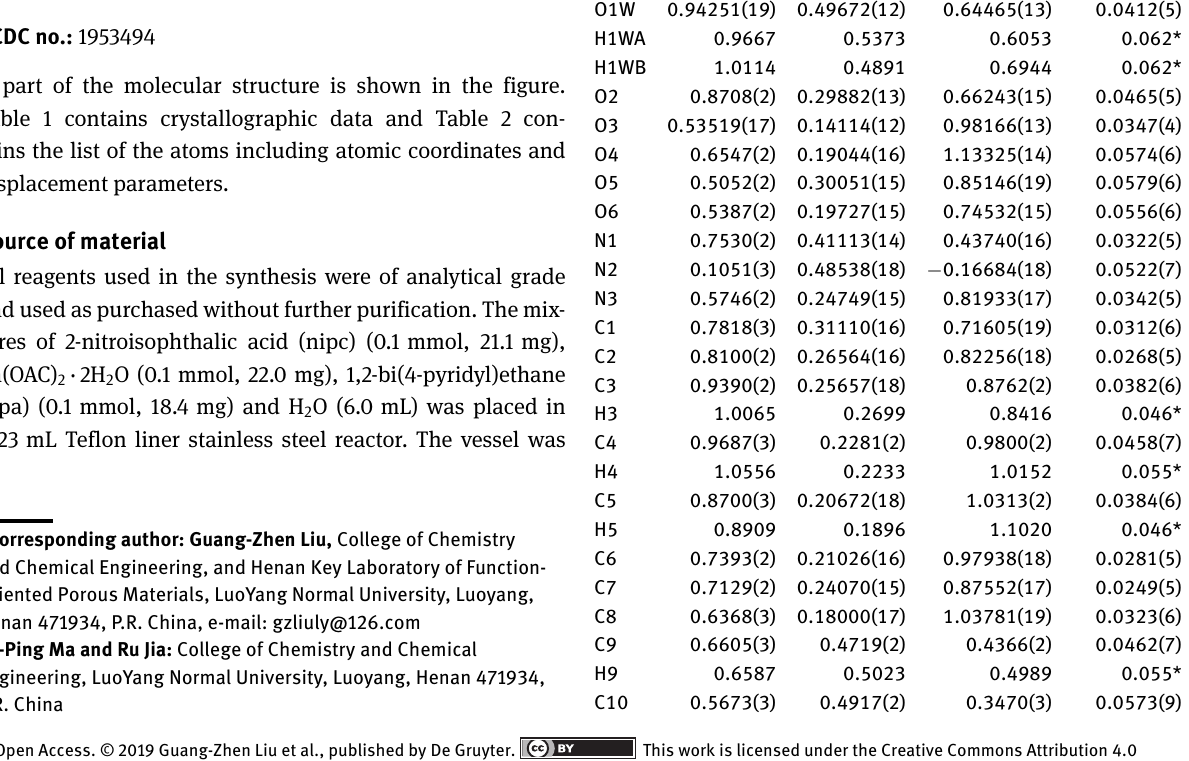
Table 1 contains crystallographic data and Table 2 con- tains the list of the atoms including atomic coordinates and displacement parameters.